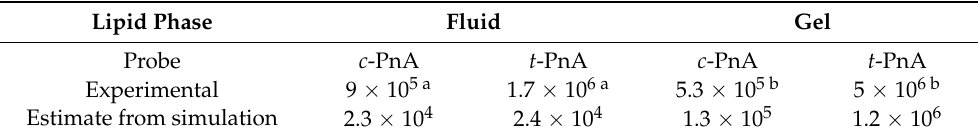
Table 2. Published experimental lipid/water partition coefficient values for c -PnA and t -PnA in both gel and fluid phases [20] and the estimates from the PMF profiles determined for the ionized PnAs in this work. Lipid Phase Fluid Gel Probe c -PnA t -PnA c -PnA t -PnA Experimental 9 × 10 5 a Estimate from simulation 2.3 × 10